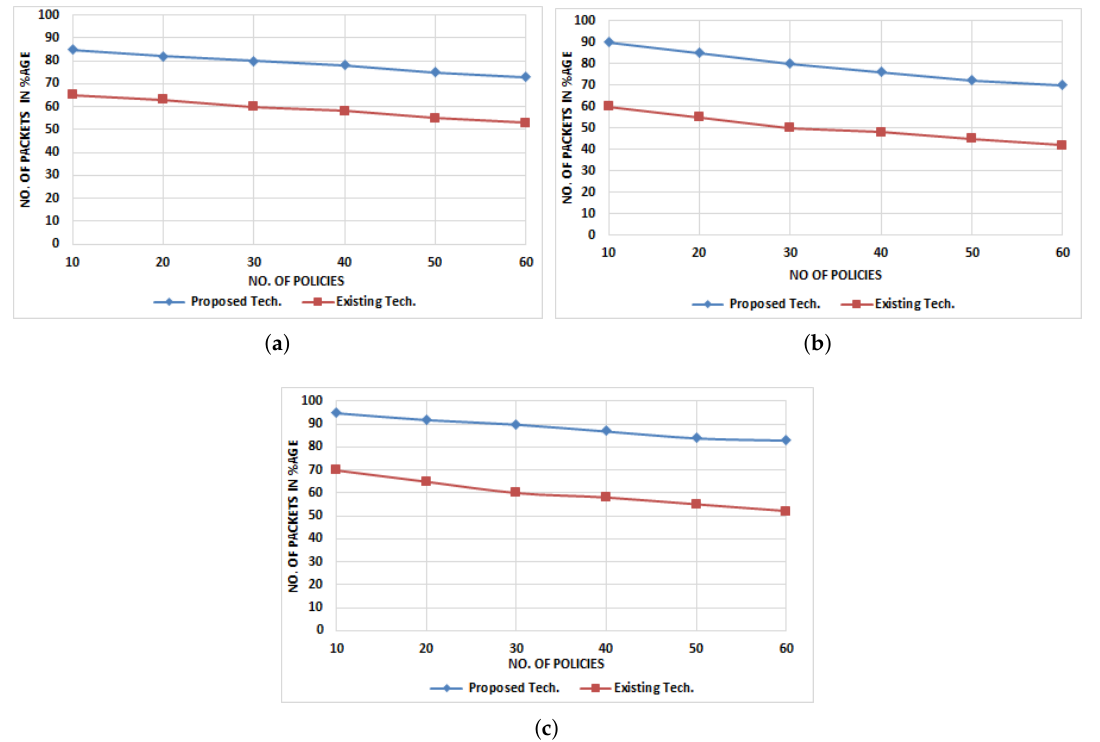
Figure 23. SPD for near the Destination policy Implementation Scheme. ( a ) SPD for near the Source policy Implementation Scheme; ( b ) SPD for near the Destination policy Implementation Scheme; ( c ) SPD for Optimal policy Implementation